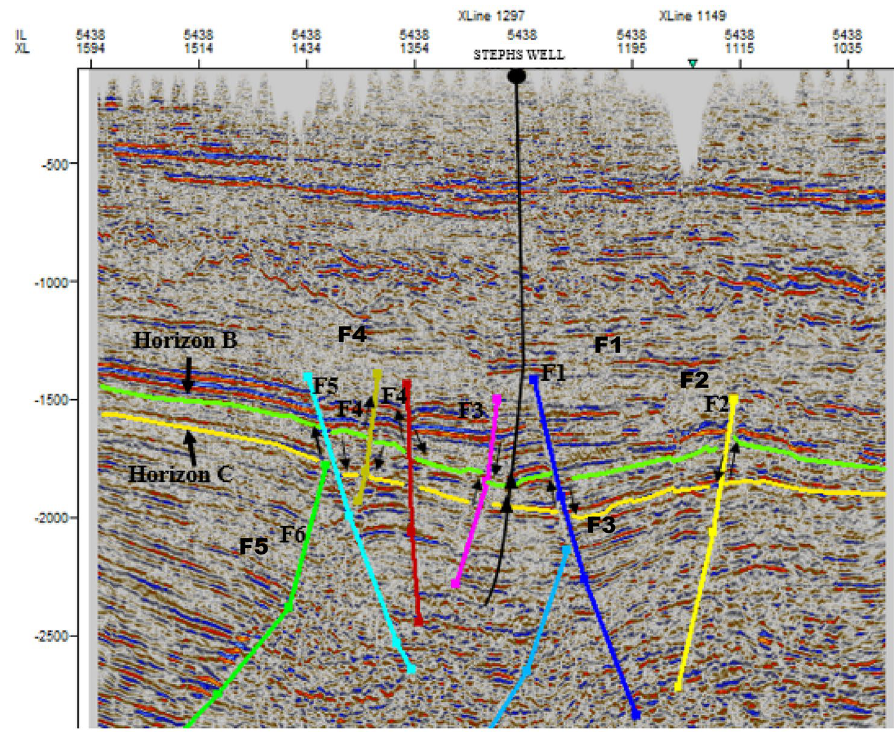
Fig. 8 Interpreted Inline 5438 on seismic section showing the mapped faults and horizons ( represents the well